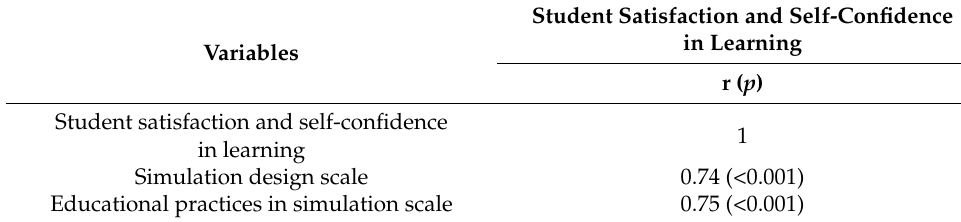
Table 4. Correlations among